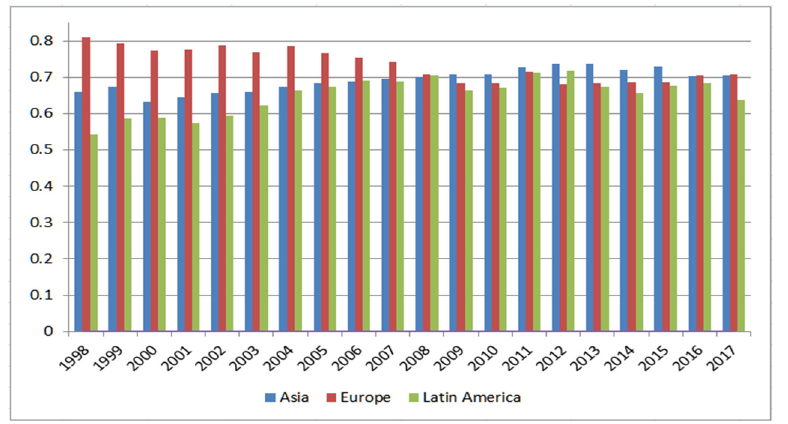
Figure 2. Comparison of energy efficiency in different continents. Data source: energy efficiency from the estimation according to Equation (7).